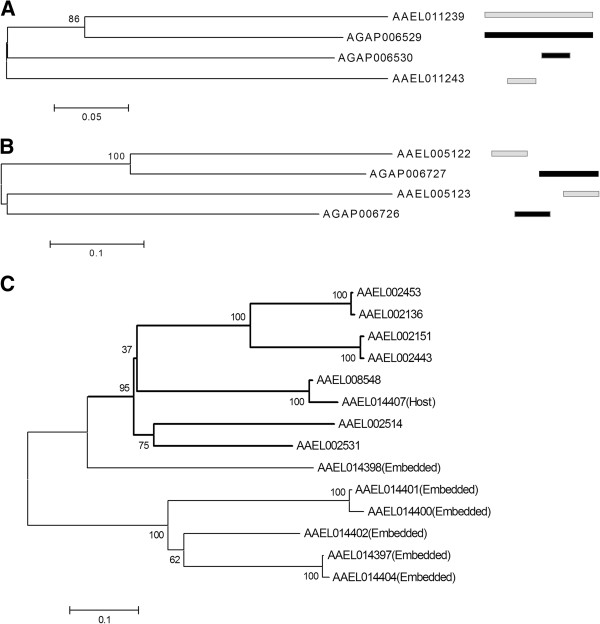
Phylogenetic (neighbor-joining trees) relationship among pairs of genes of A. aegypti (gene ID begins with AAEL; gene structural pattern shown as light color bars next to branches) and A. gambiae (gene ID begins with AGAP; gene structural pattern shown as dark color bars next to branches). The gene pairs in each case are paralogous to each other within species and at the same time they are orthologous to each other between the two species. They either retain positional overlapping structure in both the genomes (A) or show overlapping in one but non-overlapping in the other (B). The tree shown in (C) represents phylogenetic relationship of the host gene (AAEL014407) with paralogous copies in the A. aegypti genome which are either embedded (within AAEL014407) or non-embedded (located outside AAEL014407). The genes that are embedded are marked so within brackets. The scale for branch length is shown below each tree.